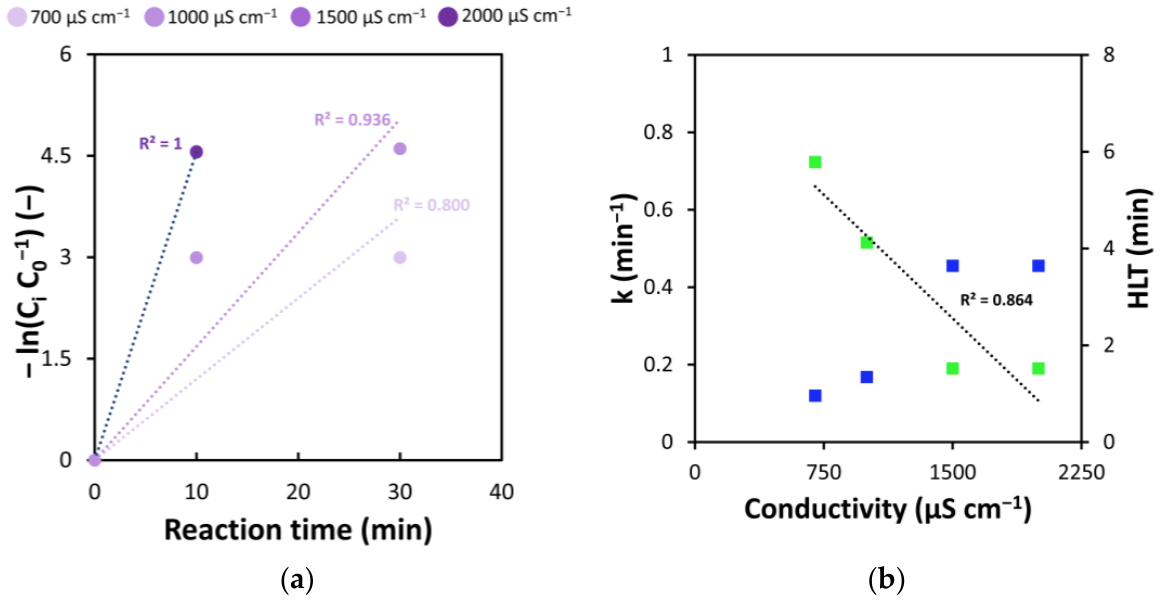
Figure 4. ( a ) Effect of initial conductivity on the electrochemical oxidation of arsenic. Initial As 3+ = 1000 µg L −1 ; pH = 8. ( b ) Pseudo first-order kinetic constants k ( blue ) and HLT ( green ) as a function of initial conductivity.